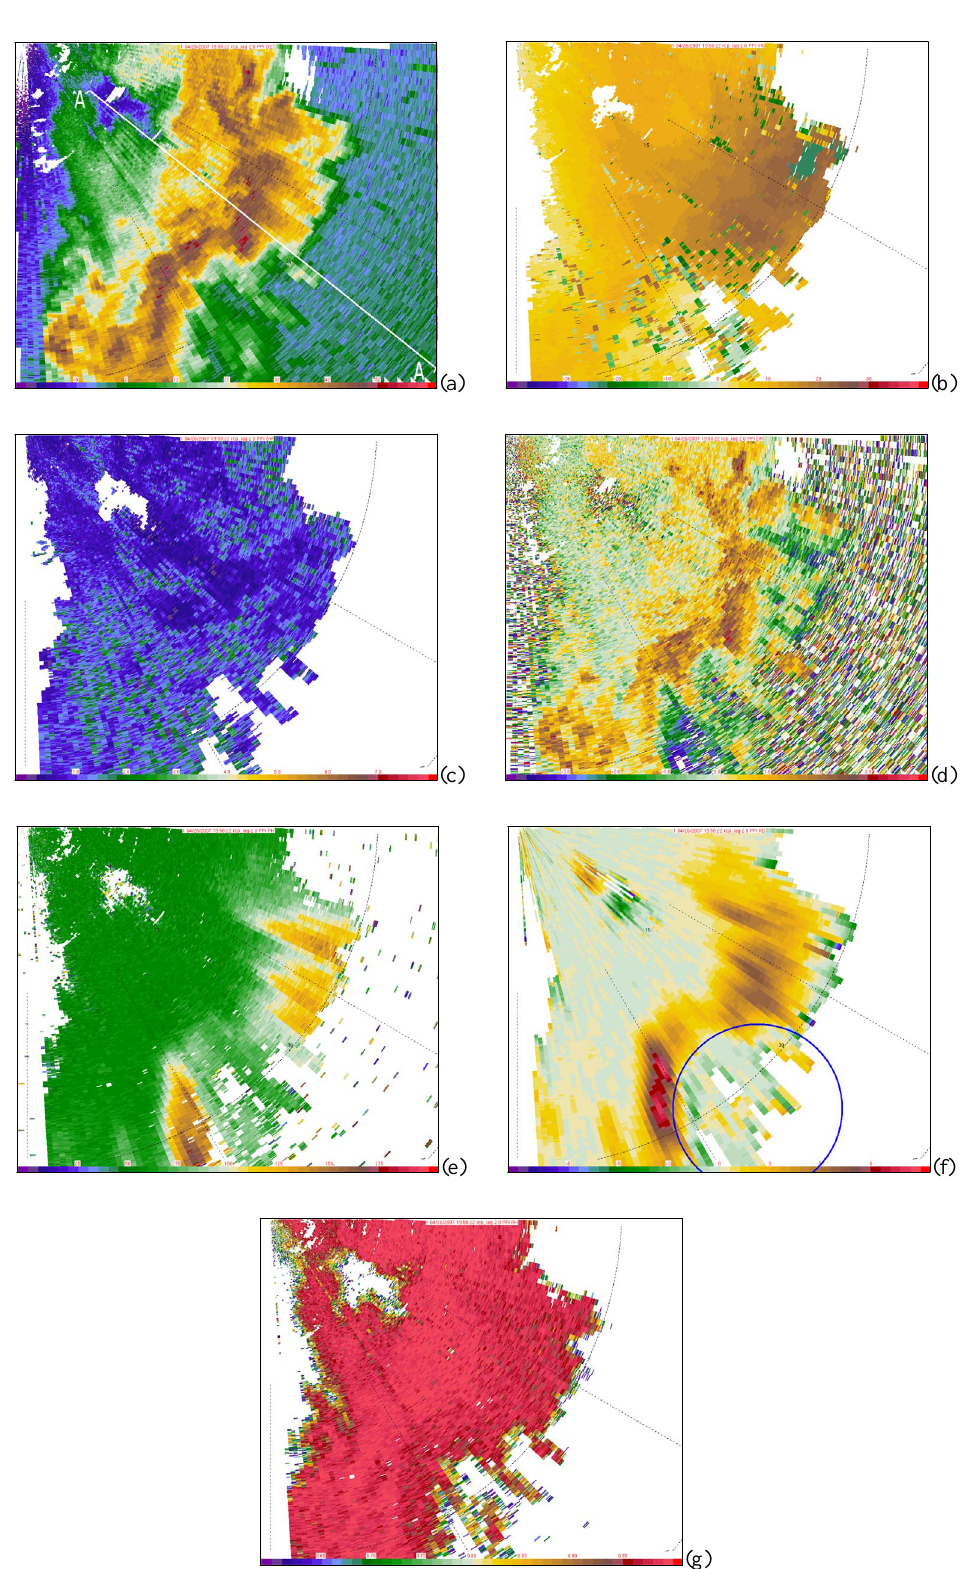
Fig. 9. 2 ◦ PPI of reflectivity – Z h (a) dBZ, radial velocity – V r (b) ms − 1 , spectral width – SW (c) ms − 1 , differential reflectivity – Z DR (d) , differential propagation phase – ϕ DP (e) degree, specific differential phase – K DP (f) degree km − 1 and correlation coefficient VH – ρ oHV (g) obtained with MXPOL at 19:50UTC on 26 April 2007. Colour scales are